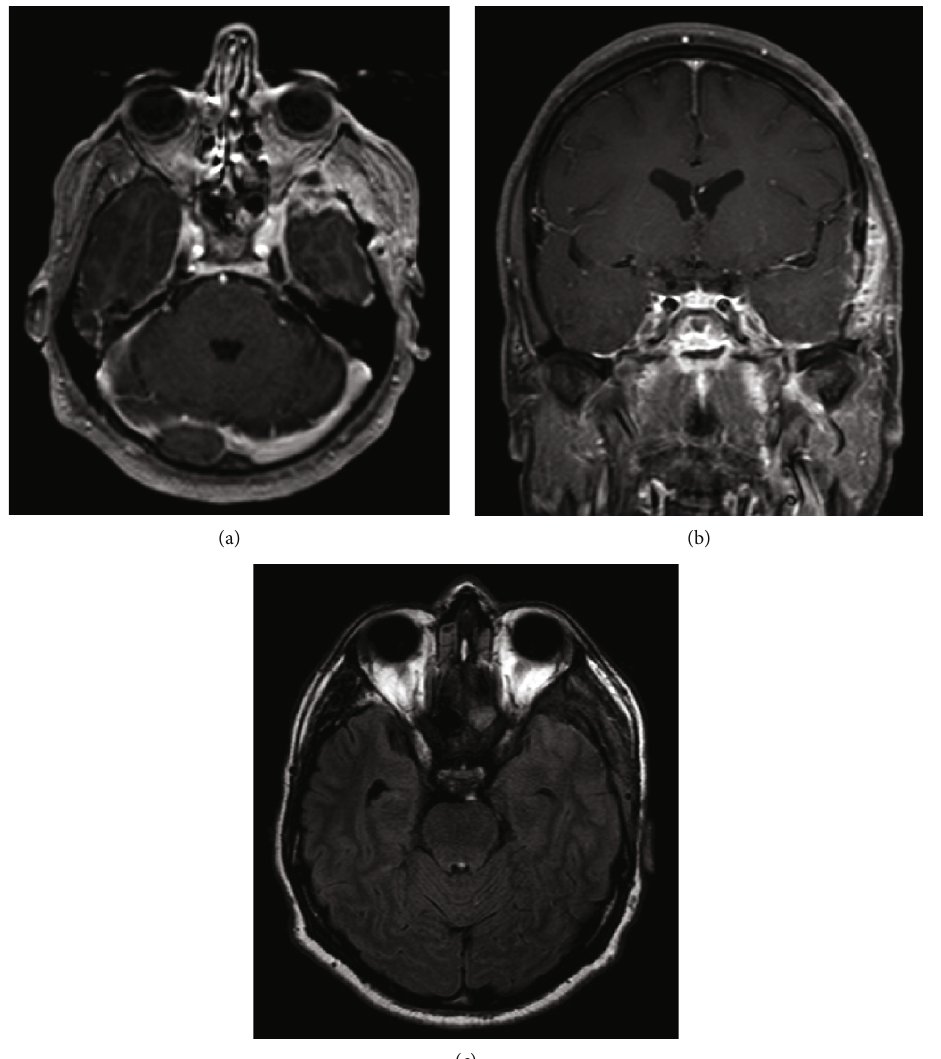
Figure 3: (a) Axial T1-weighted brain MRI with contrast. (b) Coronal T1-weighted brain MRI with contrast. (c) Axial T2-weight fl uid- attenuated inversion recovery brain MRI. (a, b) Follow-up images after 9 months of resection demonstrating persistent pachymeningeal enhancement in the left temporal lobe with no evidence abscess formation. (c) There is resolution of the vasogenic edema in the left temporal